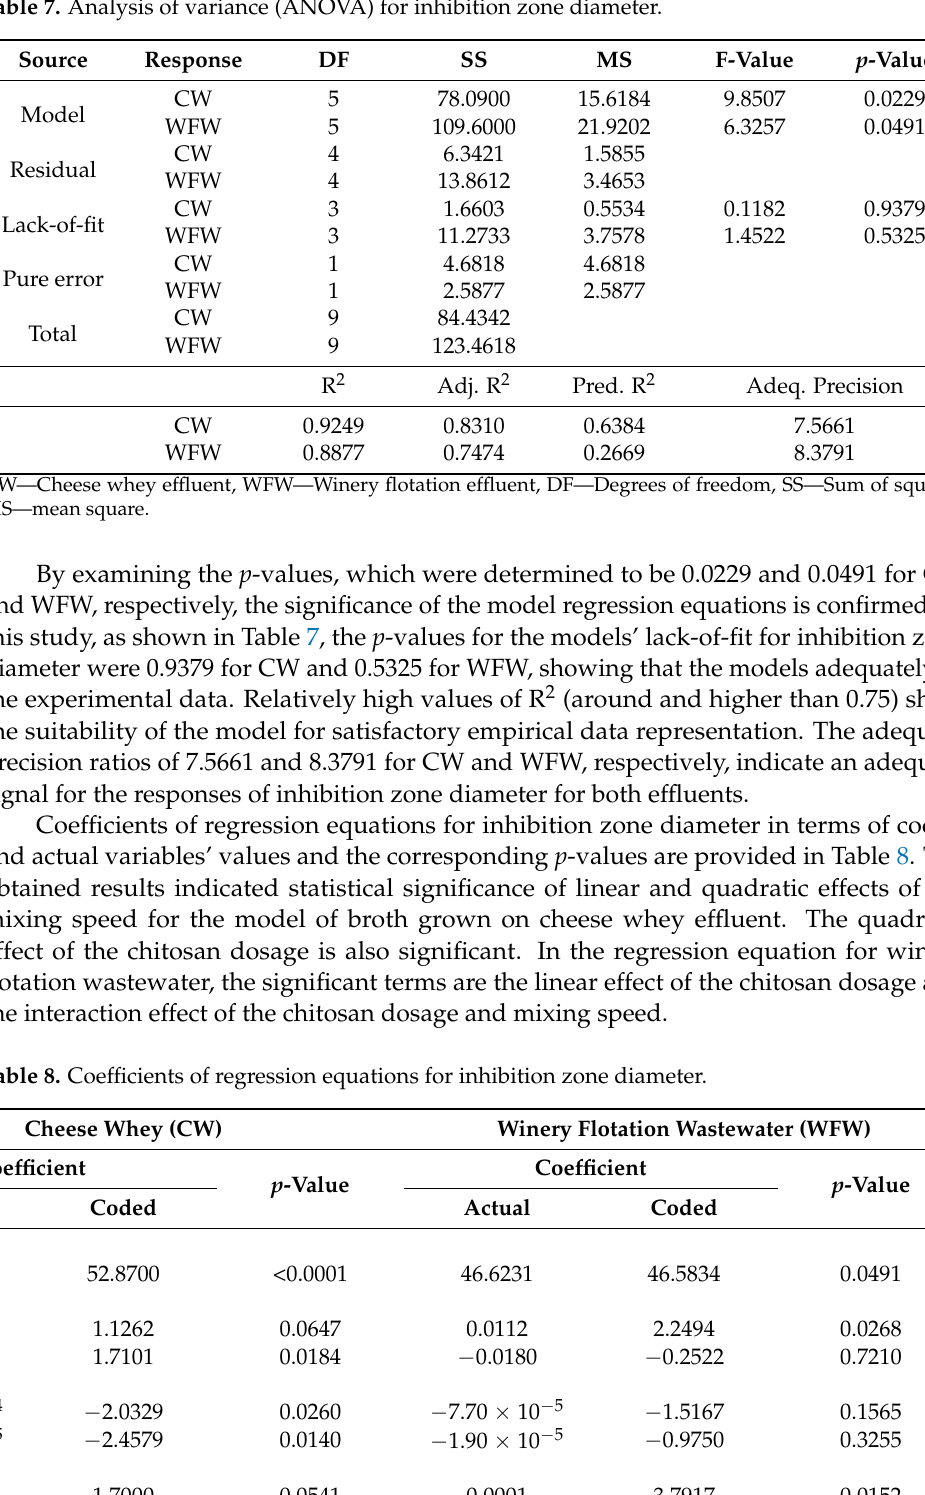
Table 7. Analysis of variance (ANOVA) for inhibition zone diameter.